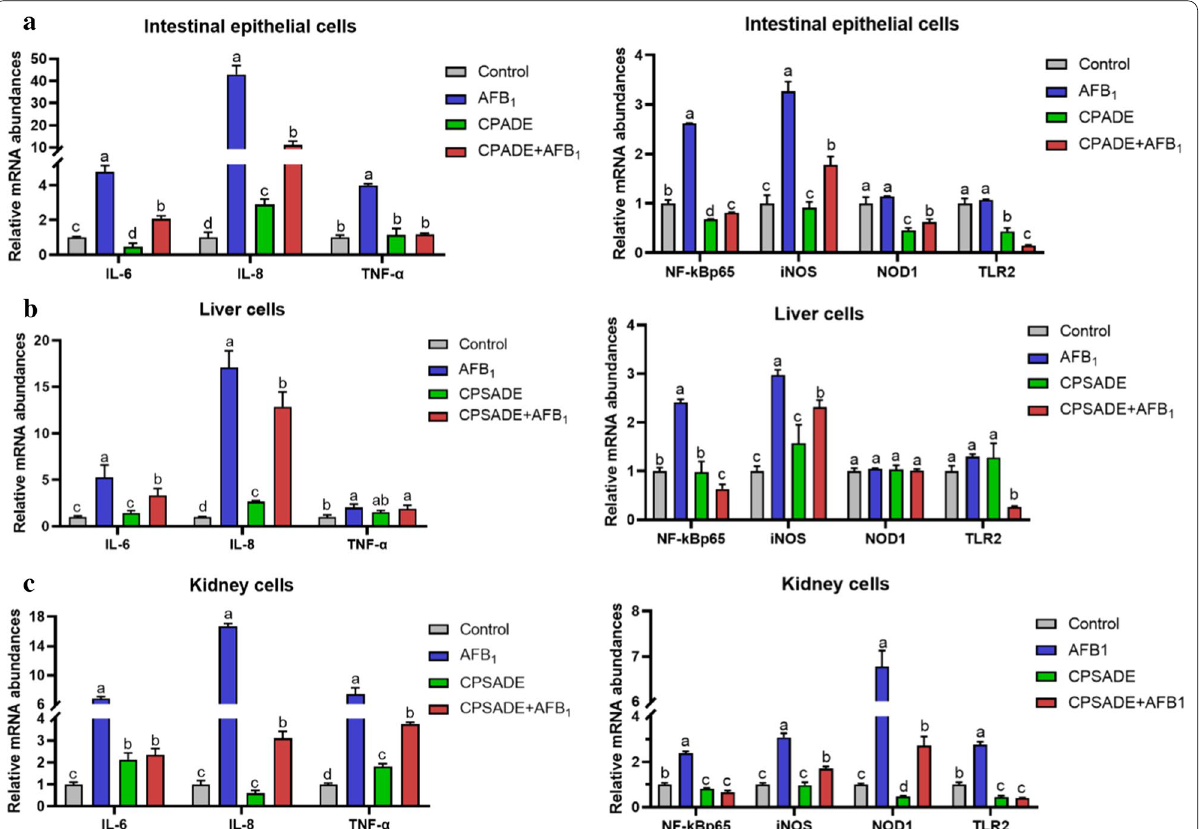
Fig. 4 Effects of CPADE or CRSADE addition on mRNA abundances of some genes in primary intestinal epithelium ( a ), liver ( b ) and kidney ( c ) cells induced by AFB 1 (n 5). The different letters on each bar indicate significant difference from each other ( p < 0.05), while the same letters on each = bar indicate insignificant difference from each other ( p > 0.05). Control: DMEM/F12 or M199; AFB 1 : 200 μg/L for primary intestinal epithelium cells, 40 μg/L for primary liver and kidney cells; CPADE: compound probiotics AFB 1 ‑degradation enzyme; CPSADE: cell‑free compound probiotics + supernatant AFB 1 ‑degradation +